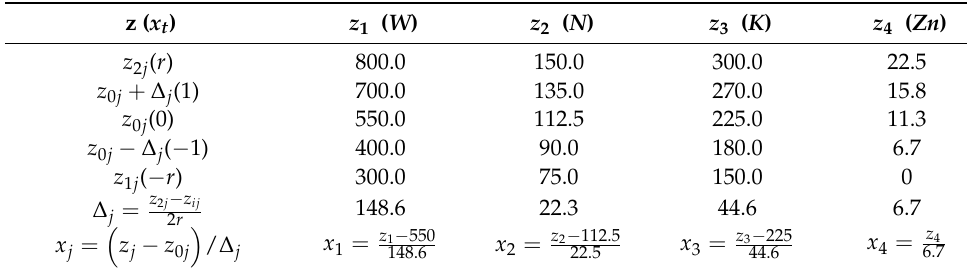
Table 1. Factor level code table for the four factors.